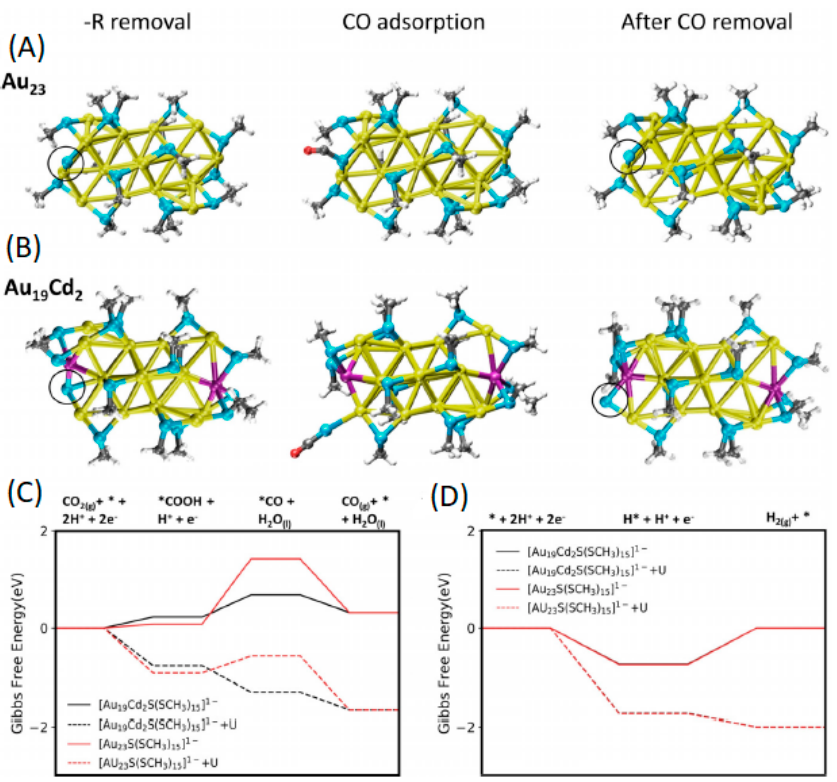
Figure 9. Optimized structures of ( A ) Au 23 (SR) 16 − and ( B ) Au 19 Cd 2 (SR) 16 − , upon –R(CH 3 ) removal, CO adsorption and CO removal. Atom colors: Au: yellow, Cd: pink, S: blue, C: black, H: white. Black circle demonstrates S active site. Reaction pathway for ( C ) CO 2 RR and ( D ) HER on the Au 23 (SR) 16 − (red lines) and Au 19 Cd 2 (SR) 16 − (black lines) upon –CH 3 removal. Solid lines represent free energy without an applied potential, while dotted lines represent those with an applied potential of − 1.0 V vs. RHE. Adapted from Reference [59]. Copyright by Wiley-VCH (2021).